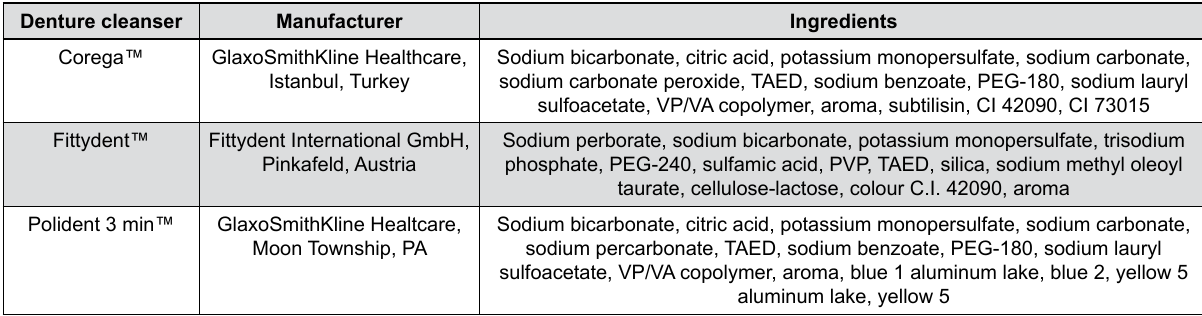
Figure 1- The chemical content of the Corega™, Fittydent™ and Polident 3